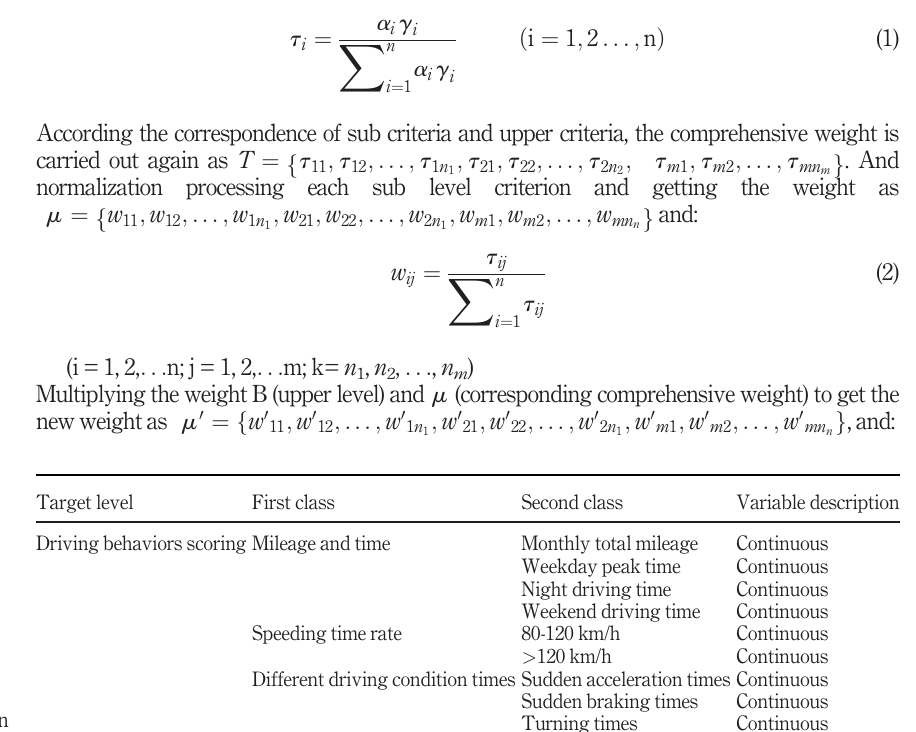
Table I. Behavior evaluation indices